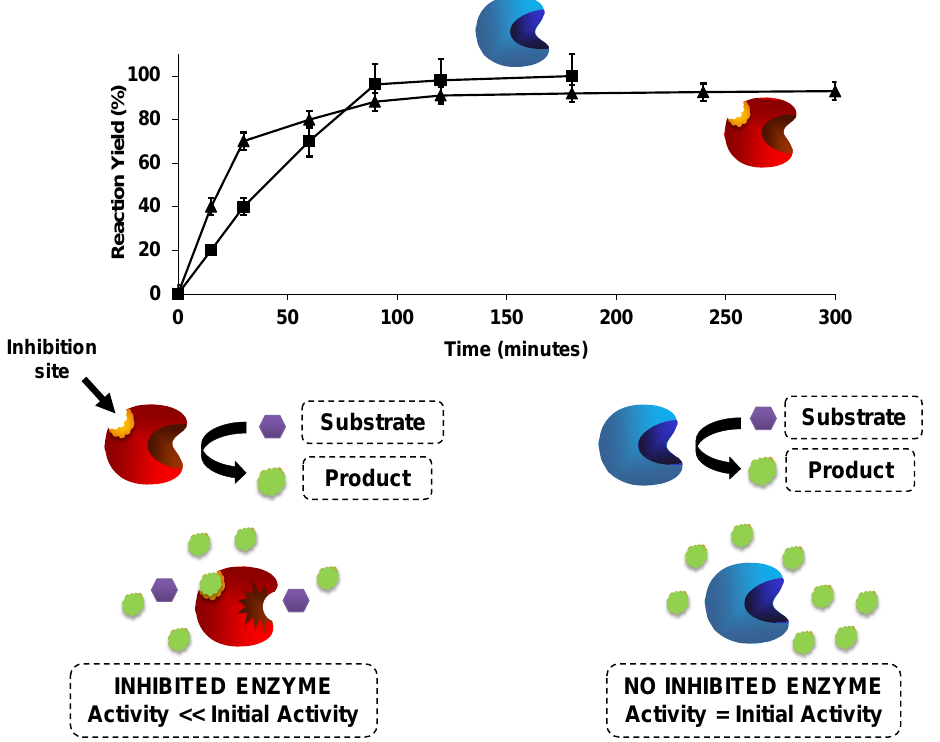
Figure 2. Effect of the product inhibition on the reaction courses using two hypothetic enzymes, one with a very high initial activity but showing a strong inhibition by the product, the other with a lower activity but without product inhibition.